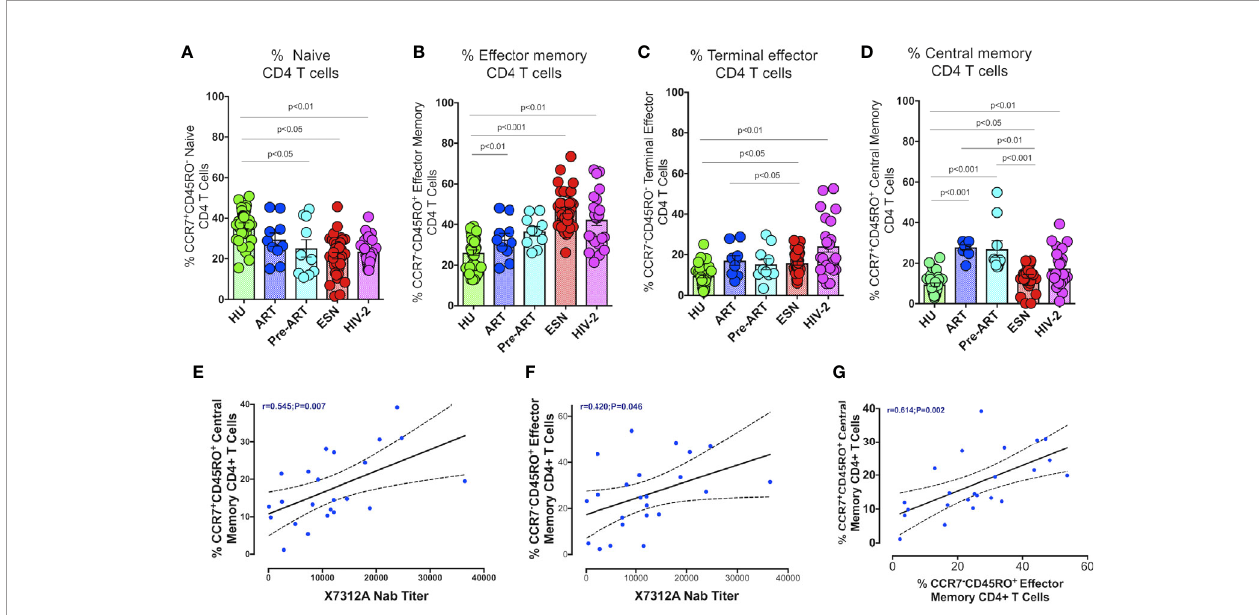
FIGURE 3 | Distribution of CD4 + Memory T cell subsets in the study groups. Graphical representation showing the enumeration of CD4 + Memory T cells subsets de fi ned using CCR7 and CD45RO expression. (A) Frequency of CCR7+CD45RO- naïve CD4 + T cells in the HU, HIV-1+ART+, HIV-1+ART-, HIV-2 and HESN groups. (B) Frequency of CCR7-CD45RO+ Effector Memory CD4 + T cells in the HU, HIV-1+ART+, HIV-1+ART-, HIV-2 and HESN groups. (C) Frequency of CCR7- CD45RO- Terminal Effector Memory CD4 + T cells HU, HIV-1+ART+, HIV-1+ART-, HIV-2 and HESN groups. (D) Frequency of CCR7+CD45RO+ Central Memory CD4 + T cells in the HU, HIV-1+ART+, HIV-1+ART-, HIV-2 and HESN groups. The scatter dot plots summarize the % frequency of total memory T cells (median, 1st, and 3rd quartiles). P values were calculated using the K-Wallis test. Sub-group analysis was performed using Dunn ’ s test. (E) Correlation between frequency of CCR7+ CD45RO+ Central memory CD4 + T cells and X7312A neutralizing antibody titers in HIV-2 infected individuals. (F) Correlation between frequency of CCR7- CD45RO+ Effector Memory CD4 + T cells and X7312A neutralizing antibody titers in HIV-2 infected individuals. (G) Correlation between frequency of CCR7+ CD45RO+ Central Memory CD4 + T cells and frequency of CCR7-CD45RO+ Effector Memory CD4 + T cells in HIV-2 infected individuals. (Note: HU: HIV unexposed seronegative controls, HIV-1+ART+: HIV-1-infected women on ART; HIV-1+ART-: HIV-1-infected women naïve to ART; HESN: HIV exposed seronegative individuals; HIV-2: HIV-2 infected